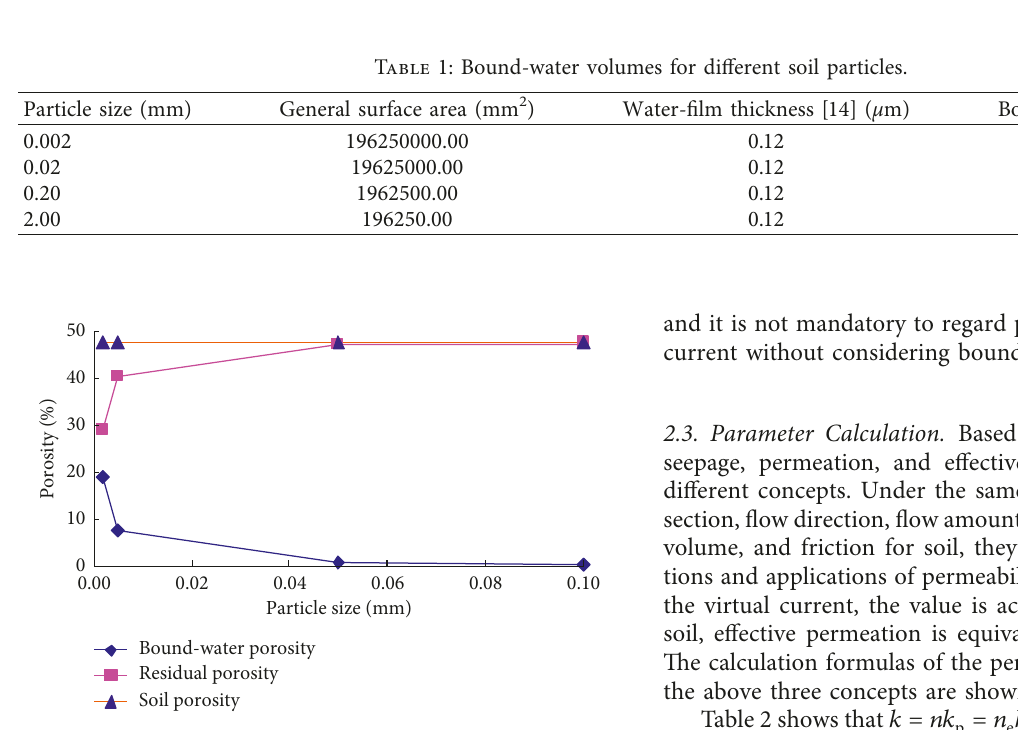
Figure 3: Curves of bound-water and residual porosities.